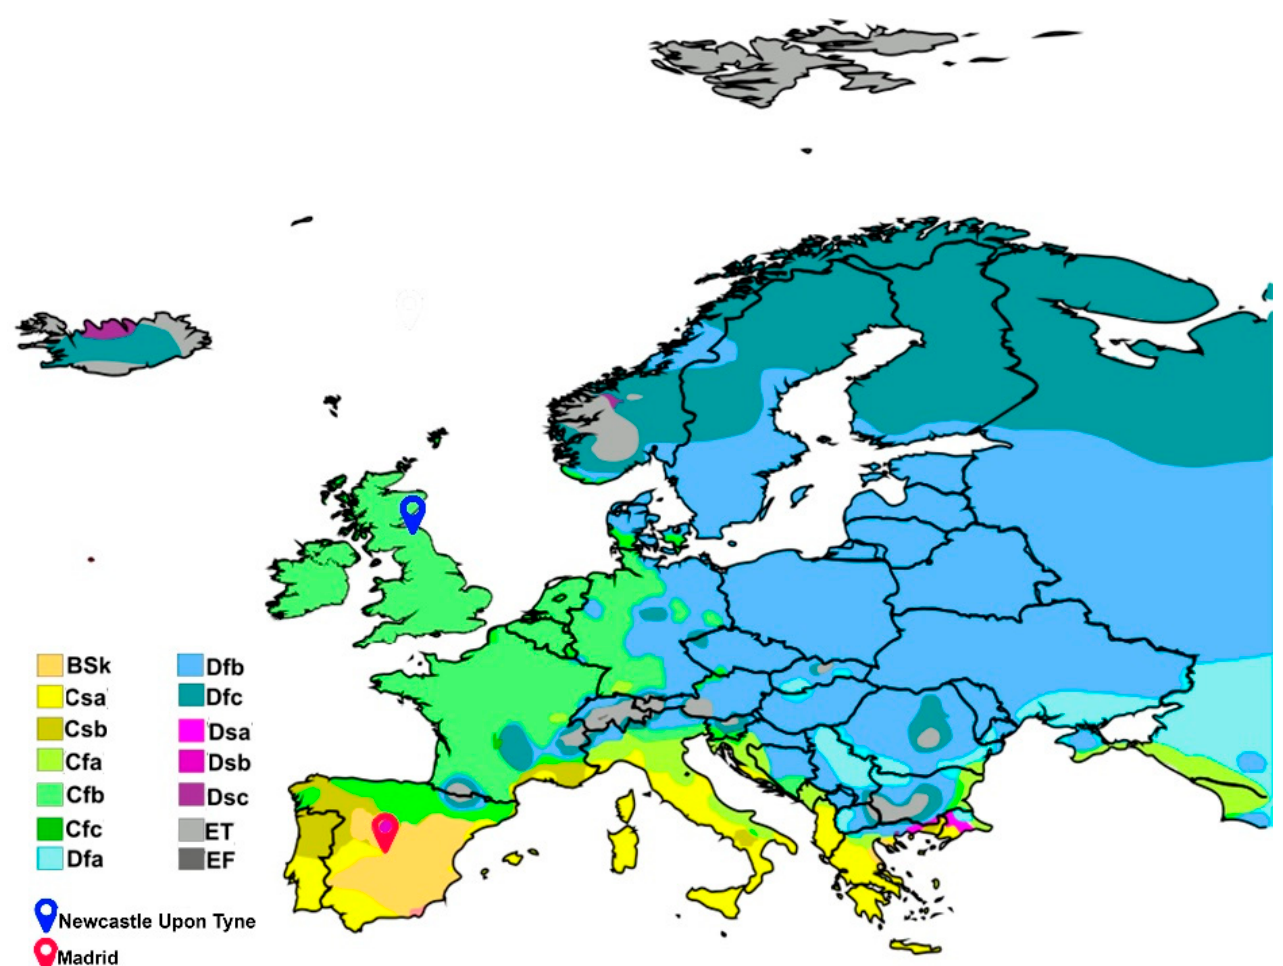
Figure 1. Case studies location in the Köppen–Geiger’s climate classification map of Europe. (BSk, cold semi-arid; Csa, hot summer Mediterranean; Csb, warm-summer Mediterranean; Cfa, humid subtropical; Cfb, oceanic climate west coast; Cfc, oceanic climate subpolar; Dfa, hot summer humid continental; Dfb, warm summer humid continental; Dfc, regular subarctic; Dsa, dry and hot summer humid continental; Dsb, dry and warm summer humid continental; Dsc, dry summer, regular subarctic; ET, tundra; EF, ice cap climate).